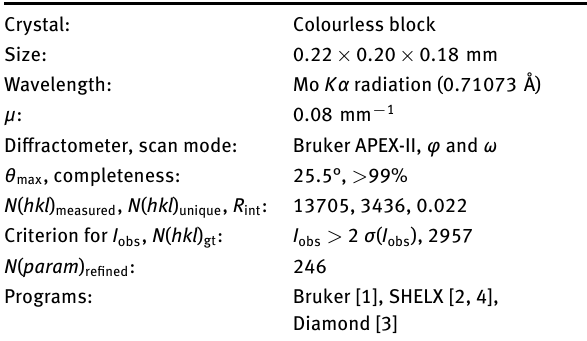
Table 1 contains crystallographic data and Table 2 contains the list of the atoms including atomic coordinates and dis- placement parameters. Table 1: Data collection and